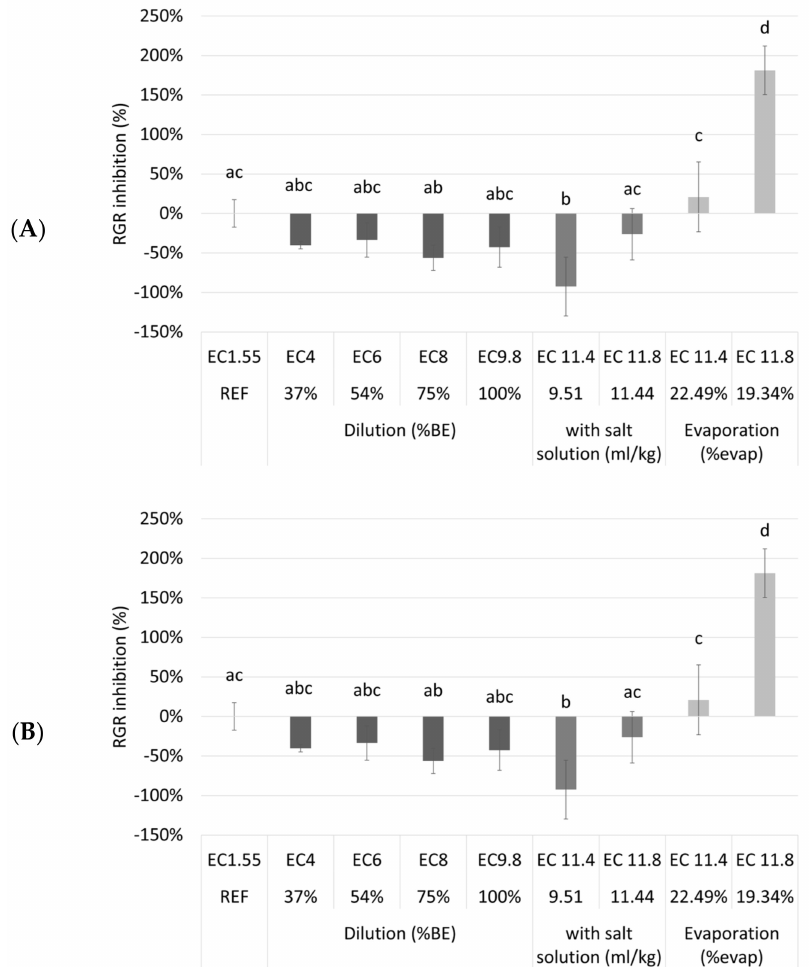
Figure 4. The relative growth rate inhibition ( A ) and the chlorophyll inhibition ( B ) of duckweed cultivated in different dilutions of NDNE, and NDNE to which a salt solution was added and in NDNE ’concentrated’ after evaporation. On the x-axis, the EC values and respectively the percentage of dilution, the concentration of salt solution or the percentage of evaporation are given. Significant differences (n = 4 and p < 0.05) per graph are indicated by different letters. Error bars indicate standard